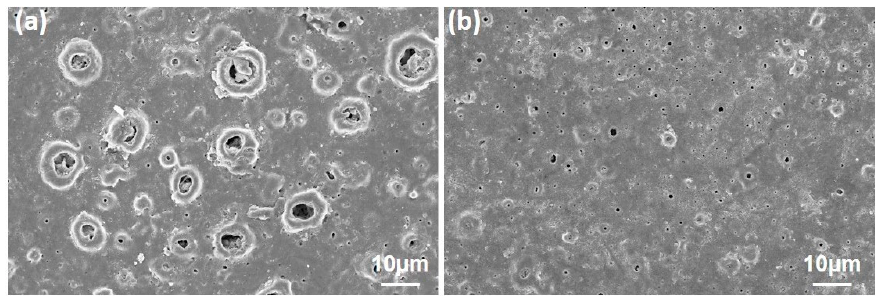
Figure 12. The corroded surfaces of ( a ) 0.5 and ( b ) 1.5 wt% GNS doped coatings at lower magnifications.